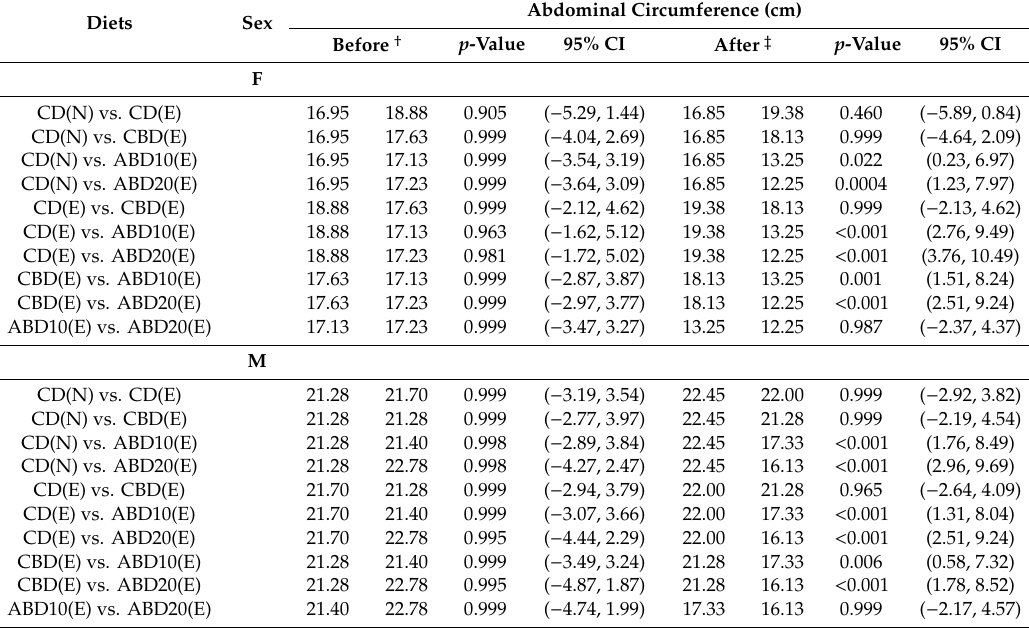
Table 3. E ff ect of 8-week consumption of diets prepared with amaranth on abdominal circumference in rats (weeks 23 to 31 of